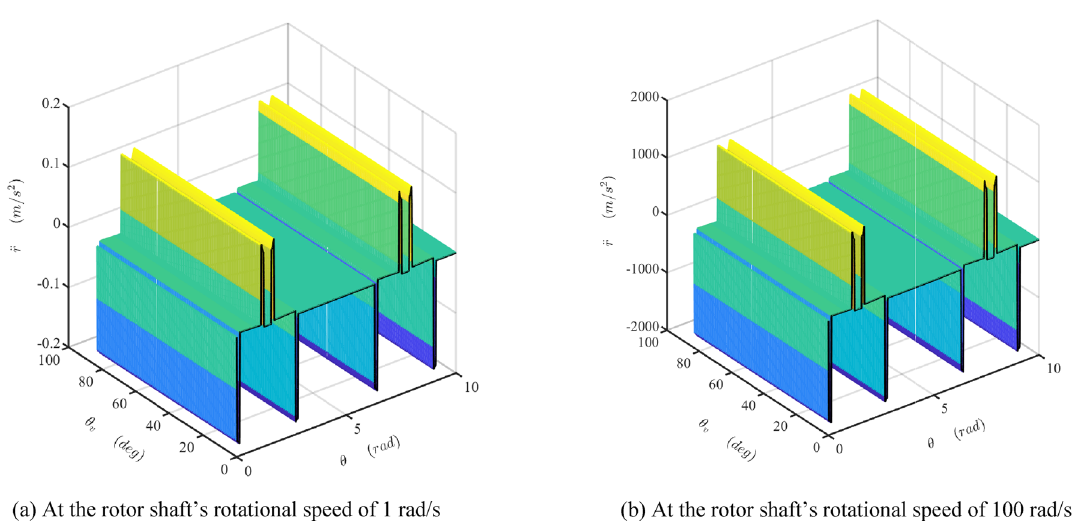
Figure 11. Extra radial acceleration map of the vane at two different the rotor shaft’s rotational speed. (Matlab2019a. https:// ww2. mathw orks. cn/ produ cts/ get- matlab. html?s_ tid= gn_